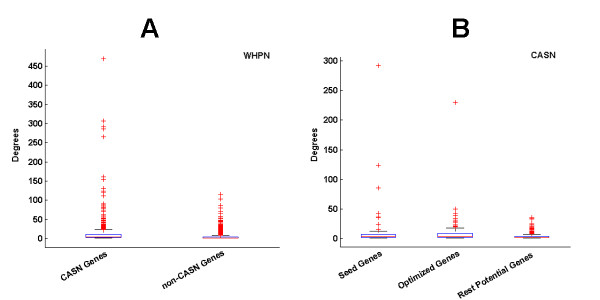
Distributions of degree for the genes in WHNP and CASN. (A) The CASN and non-CASN genes in WHPN are on the x axis; (B) The seed genes, optimized genes and rest potential genes in CASN are on the x axis. The y axis represents the degrees for these nodes. For the box plot, the top bar (black) is the lowest point within the 1.5 interquartile from the lower quartile, and the bottom bar (black) is the highest point within the 1.5 interquartile of the upper quartile, the top of box (blue) is the upper or third quartile, the bottom of box (blue) is the lower or first quartile, the middle bar is the median value. Pluses (red) are possible outliers.